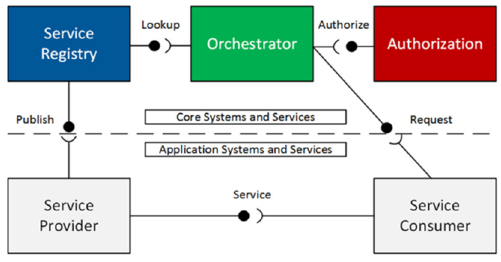
Figure 23. Open source system in Arrowhead Framework [20].